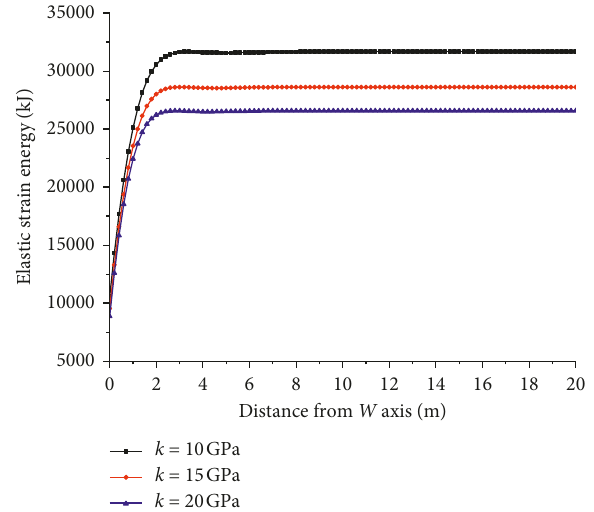
Figure 6: Distribution curves of anticlinal elastic strain energy with different foundation stiffness.